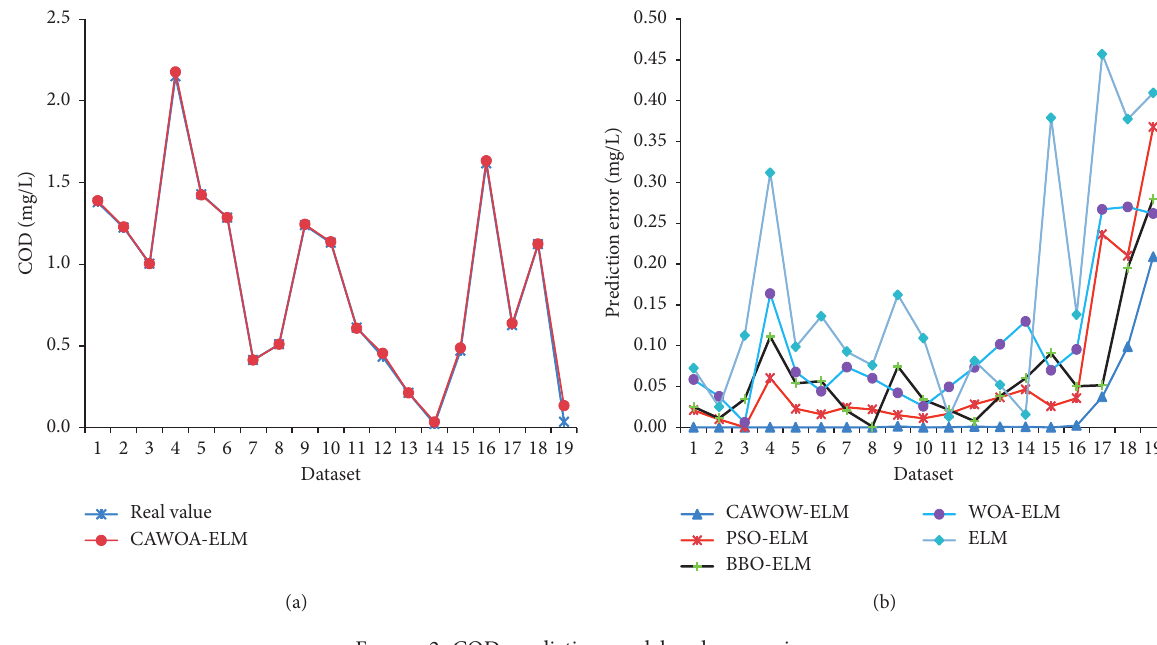
Figure 2: COD prediction model and comparison.